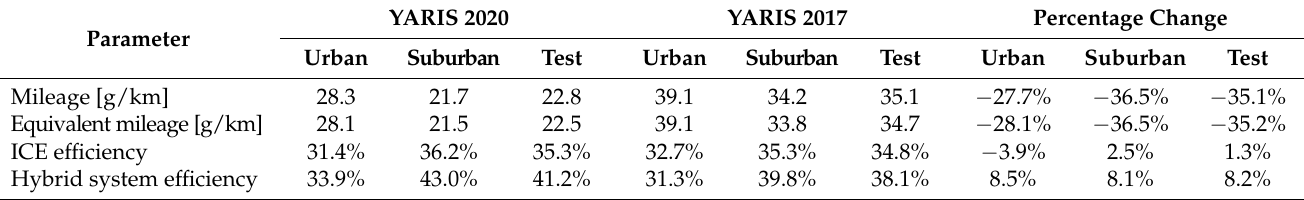
Table 4. Summary energy analysis parameters value of Yaris Hybrid 2017 and 2020. Parameter